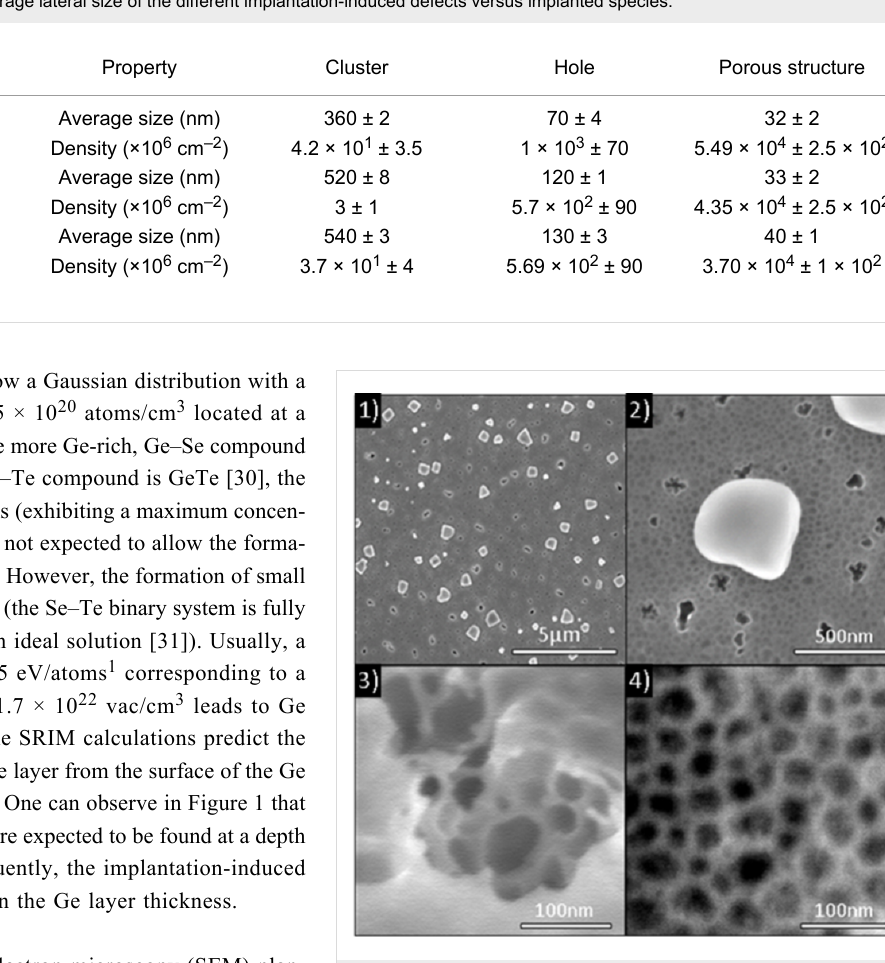
Figure 2: SEM plan-view images of the as-implanted Se sample: (1) low resolution view showing the different types of defects; (2) a single GeO x cluster; (3) the structure of holes; and (4) the nanoporous